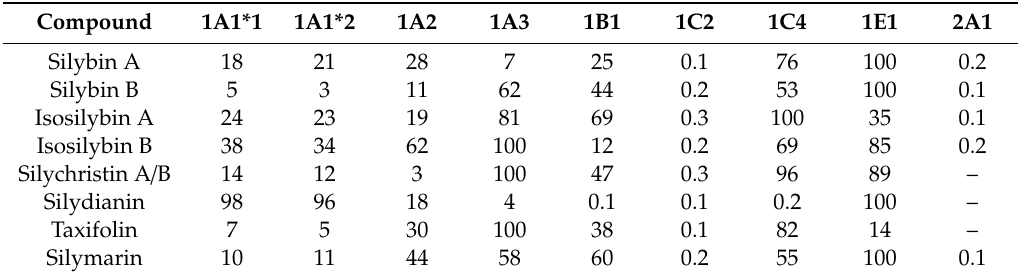
Table 2. Relative activity (%) of human sulfotransferases towards silymarin constituents.